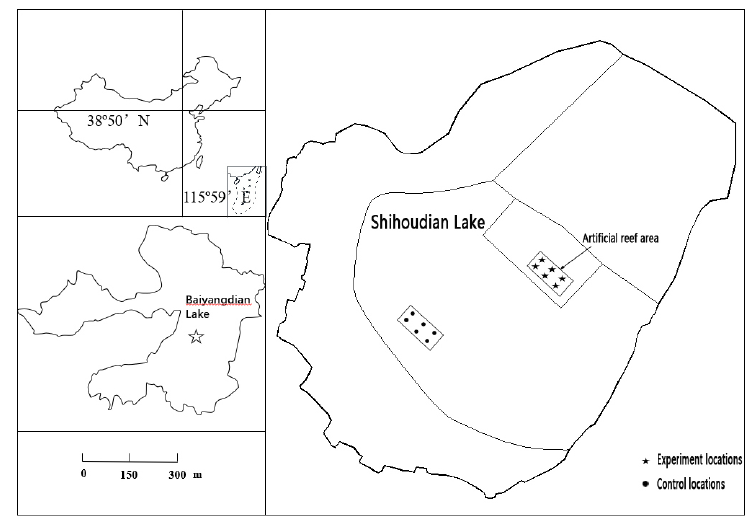
Figure 1. The layout of the experimental